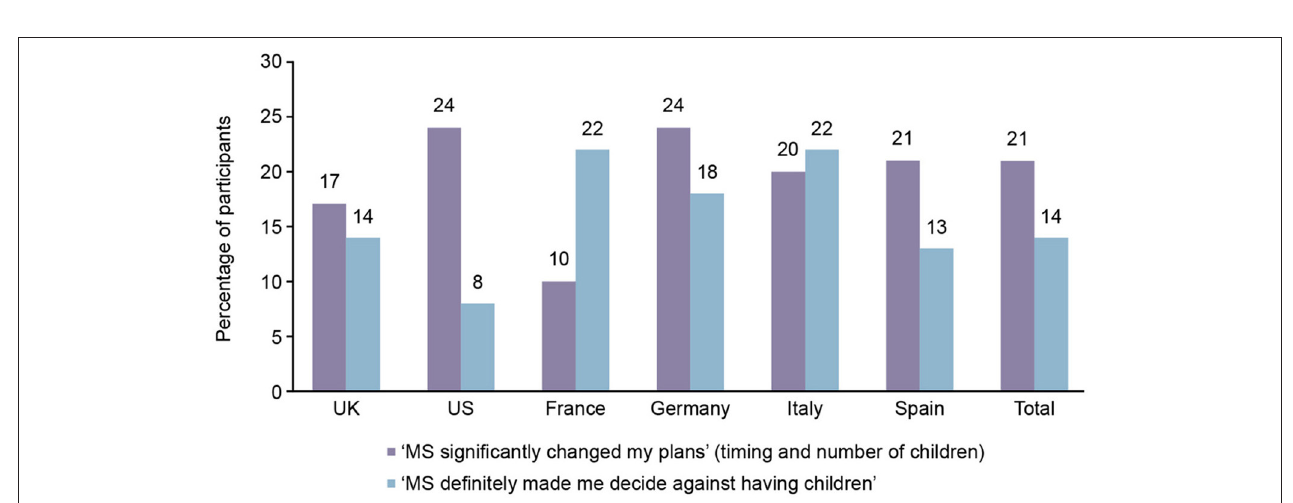
FIGURE 3 | Participants who were significantly impacted by multiple sclerosis (MS) on having children, by country.